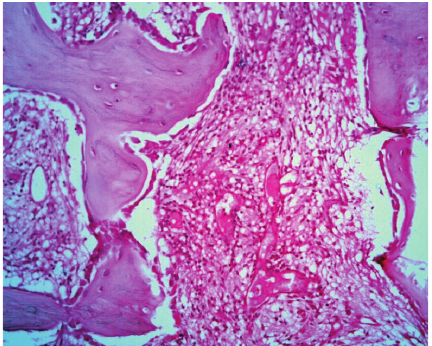
Figure 4: Photomicrograph of diffuse large B-cell lymphoma of iliumshowingsheetsofmedium-sizedatypicallymphoidcells(H&E stain, ×